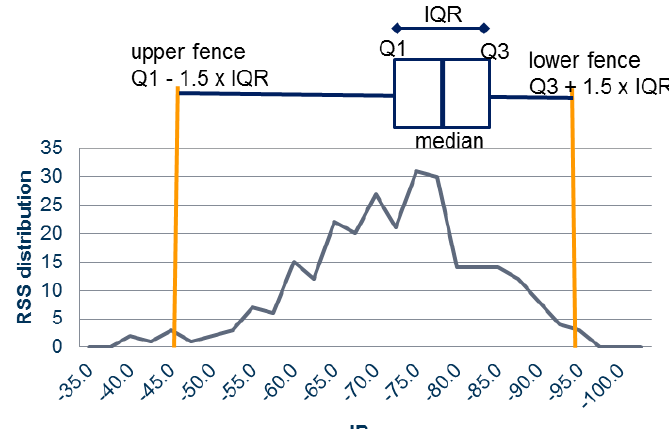
Figure 5. IQR based outlier upper and lower fence of an inter-BS neighbor